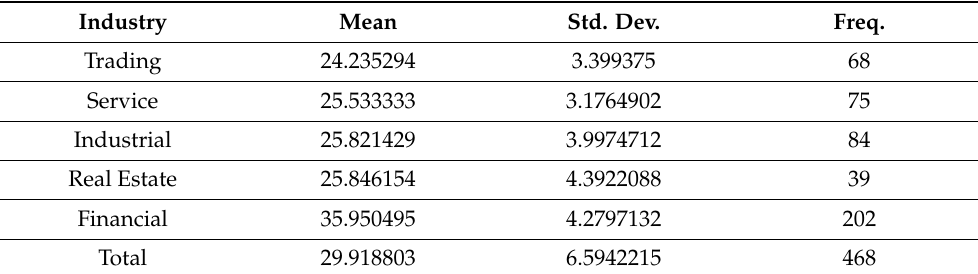
Table 4. Summary of all FI disclosures.